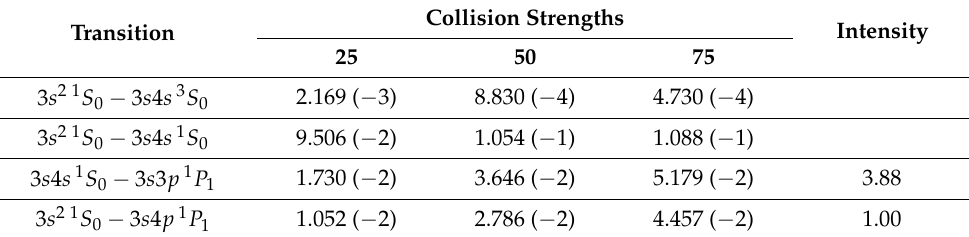
Table 10. Collision strengths at 25, 50, and 75 Ry, and intensity ratios for four transitions in Fe XV are given.